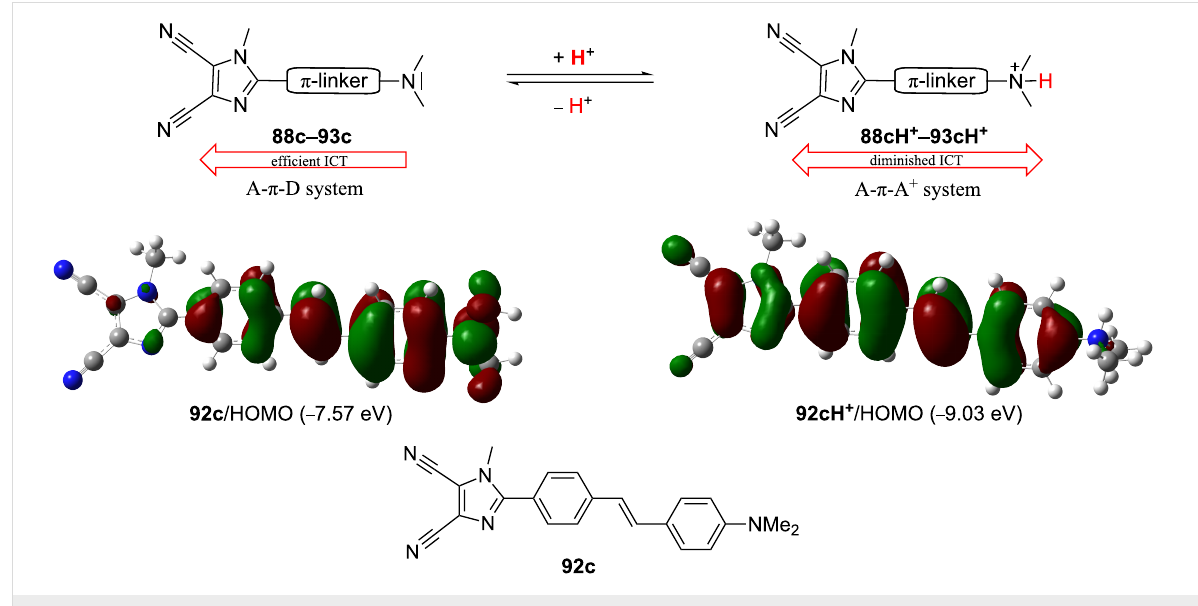
Figure 17: pH-triggered NLO switches 88c – 93c [109].